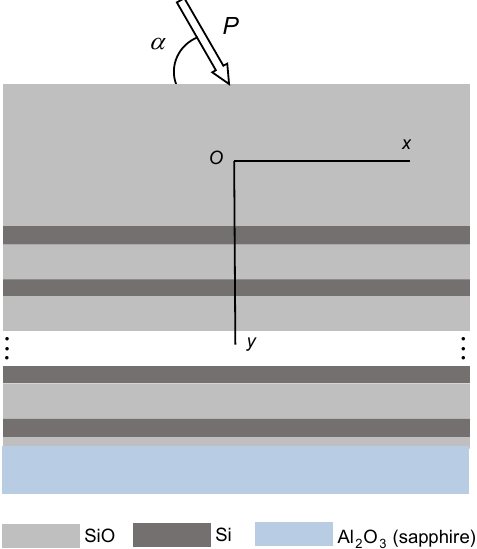
Figure 2. A fragment of the laminated filter under inclined loading.